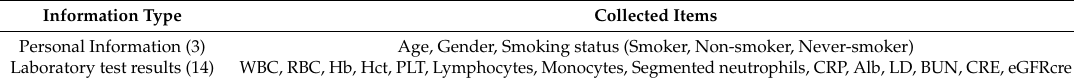
Table 1. Collected data from electronic medical records (EMRs) in this study.